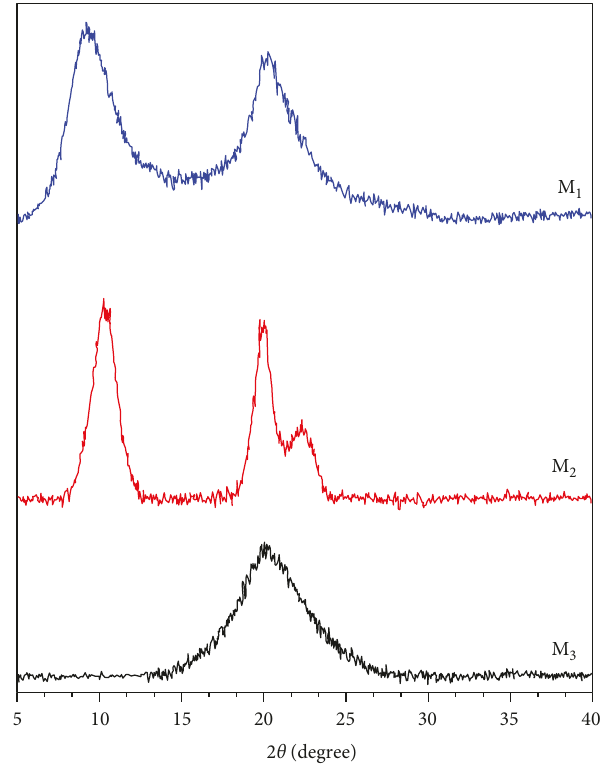
Figure 2: XRD of M1, M2, and M3.